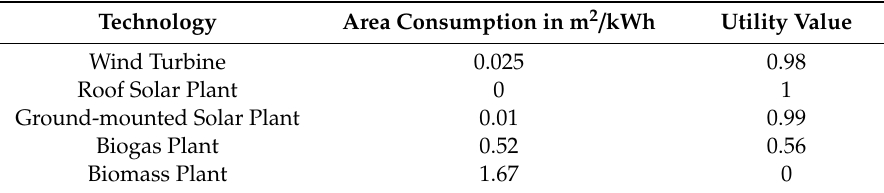
Table 4. Area requirements and utility value of di ff erent renewable energy